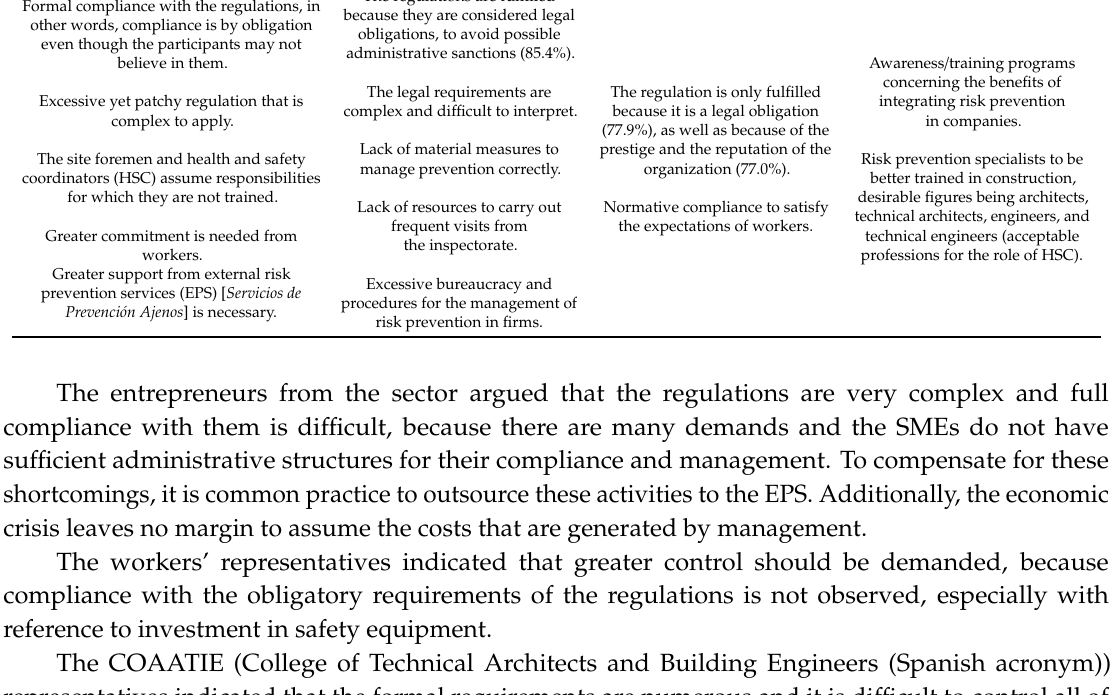
Table 4. Conclusions drawn from focus group 1 and the Second European Survey of Enterprises on New and Emerging Risks (ESENER-2, in both its Spanish and European versions), referring to the first indicator (regulation in matters of occupational risk prevention in the construction sector and level of compliance) used as a guide in discussion groups. Source: [61,62].